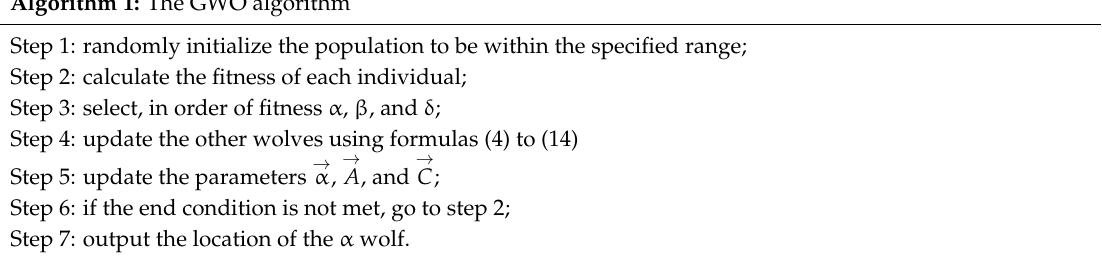
Algorithm 1: The GWO